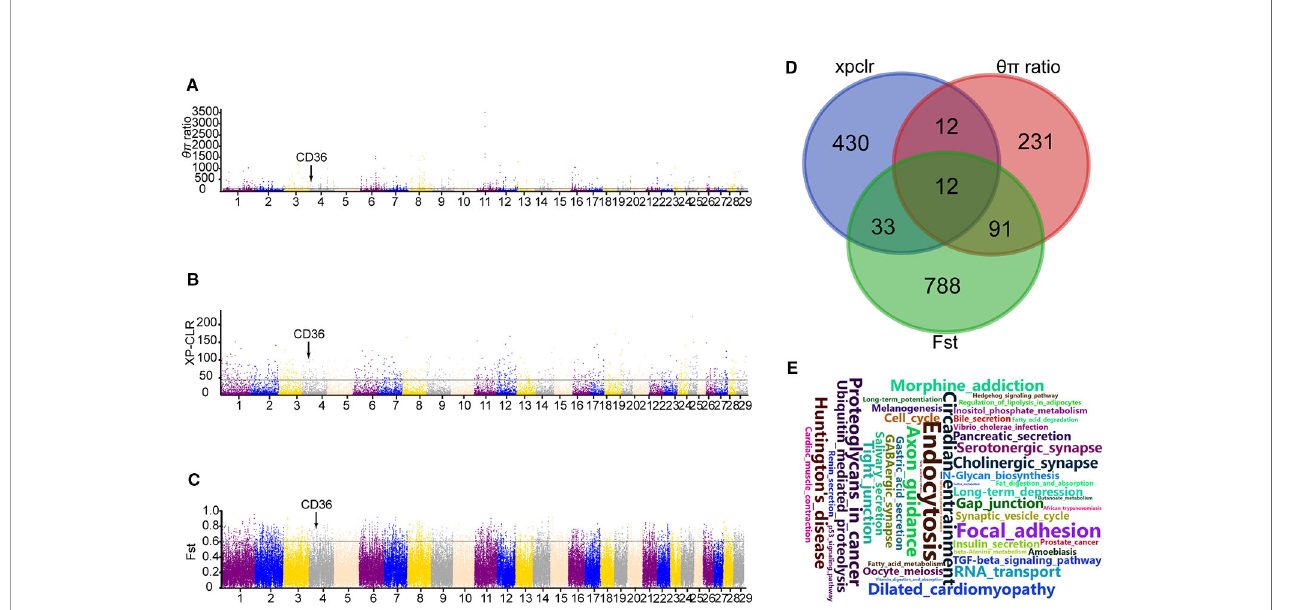
FIGURE 2 | Genome-wide selection scan between Yanbian and N ’ Dama cattle. (A – C) Manhattan plot of the genome-wide distribution of qp ratio, XP-CLR, and Fst between Yanbian and N ’ Dama cattle using 50 kb windows size and 20 kb step size, respectively. The threshold corresponding to the top 0.5% of qp ratio, XP-CLR, and Fst are marked with a horizontal line, respectively. (D) Venn diagram showing the genes overlap among qp ratio, XP-CLR, and Fst signi fi cant selection region. (E) Word cloud illustrating major enrichment pathway of these genes in qp ratio, XP-CLR, and Fst signi fi cant selection